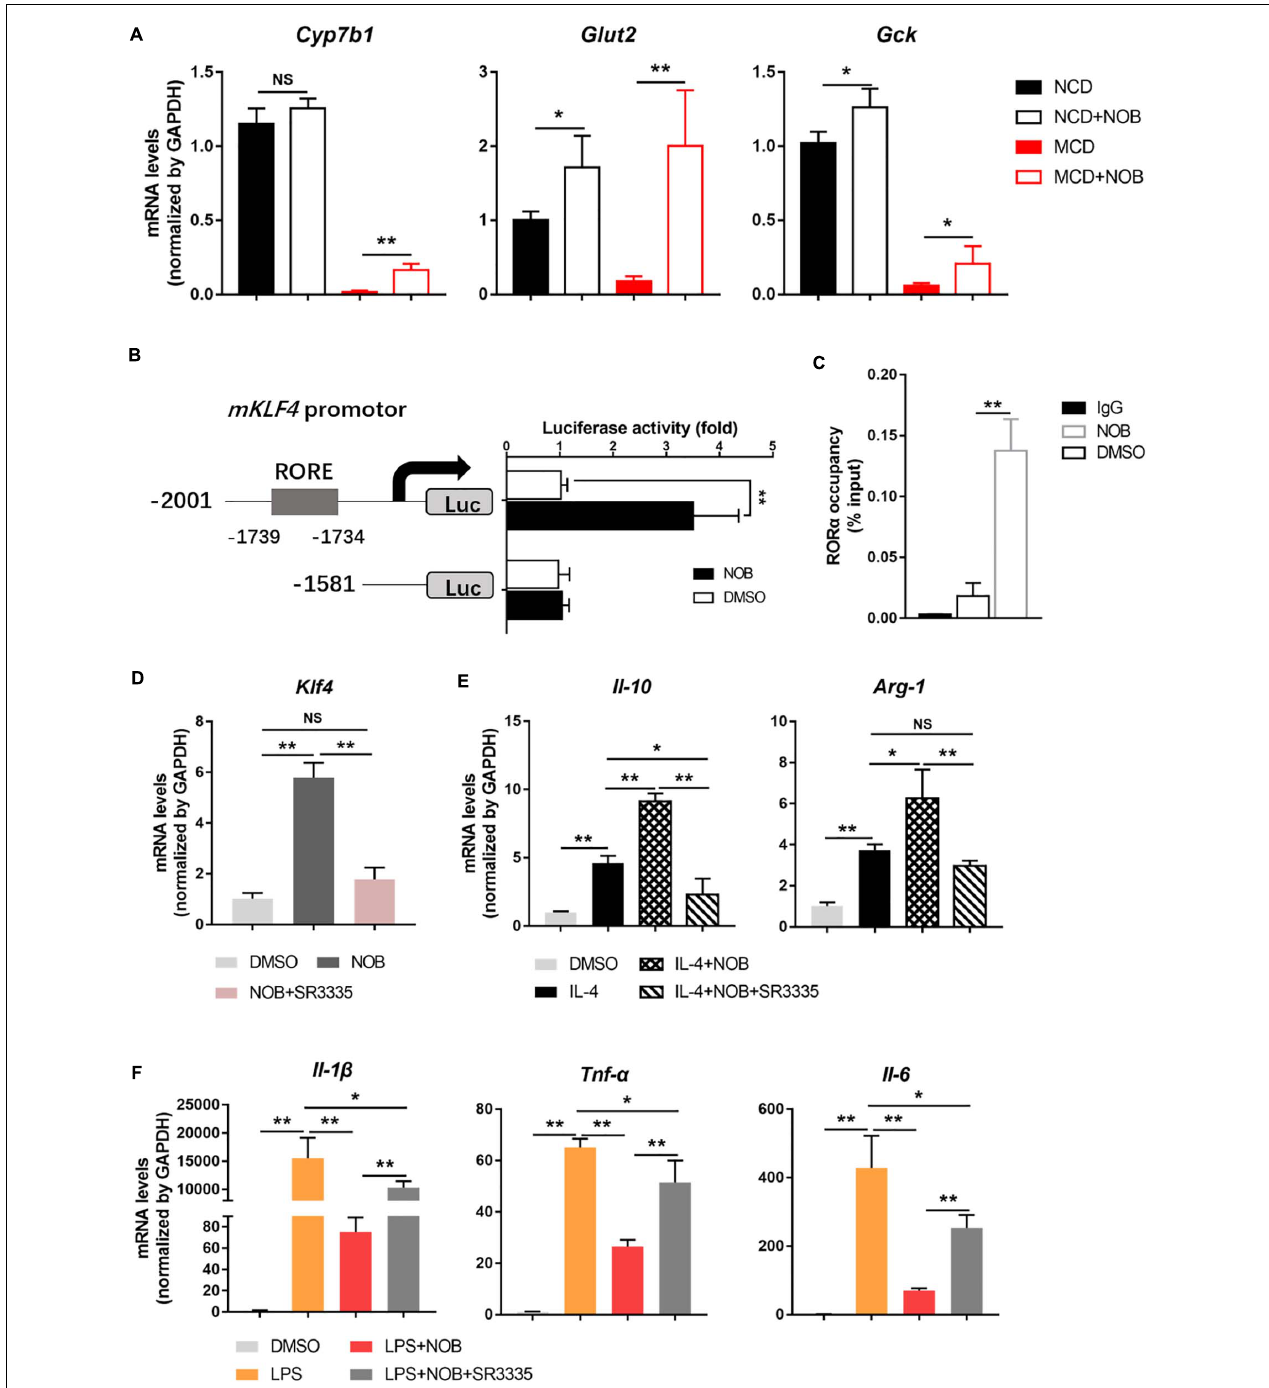
FIGURE 7 | NOB induces Klf4 expression and macrophage polarization through activiting ROR α . (A) RT-qPCR analysis of ROR α target genes Cyp7b1 , Glut2, and Gck in the livers of MCD-fed mice. Data were expressed as the mean ± SD ( n = 5). (B) Schematic diagram of the mouse Klf4 promoter with the ROR α binding element (RORE) shown as gray box. 293T cells were transfected with luciferase reporters driven by Klf4 promoter with or without RORE and treated with DMSO or NOB (100 µ M) for 8 h. (C) RAW 264.7 cells were treated with DMSO or NOB (100 µ M) for 16 h. The binding of ROR α to Klf4 promotor was assessed by ChIP-qPCR. (D) RAW 264.7 cells were treated with DMSO, NOB (100 µ M) or SR3335 (10 µ M) for 16 h. The mRNA level of Klf4 determined by RT-qPCR. (E) RAW 264.7 cells were treated with DMSO, IL-4 (20 ng/mL), IL-4 (20 ng/mL) + NOB (100 µ M) or IL-4 (20 ng/mL) + NOB (100 µ M) + SR3335 (10 µ M) for 16 h. The mRNA levels of Arg-1 and Il-10 determined by RT-qPCR. (F) RAW 264.7 cells were pretreated with DMSO, LPS (200 ng/mL), LPS (200 ng/mL) + NOB (100 µ M) or LPS (200 ng/mL) + NOB (100 µ M) + SR3335 (10 µ M) for 16 h. Proinflammatory factors Il-6 , Il-1 β , and Tnf- α determined by RT-qPCR. Values are expressed as mean ± SD ( n = 3). * P < 0.05, ** P <